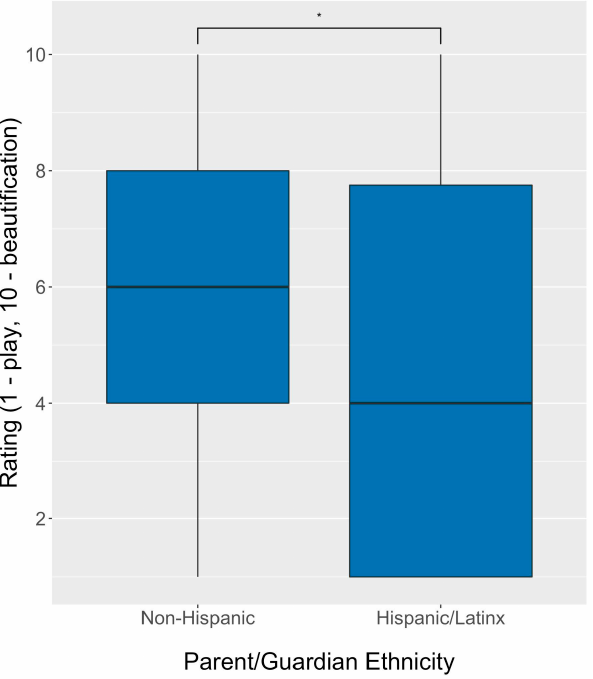
Figure 4. CMBP-use motivation scale (play–beautification rating) by parent/guardian ethnicity ( n = 217). * p -value = 0.039.